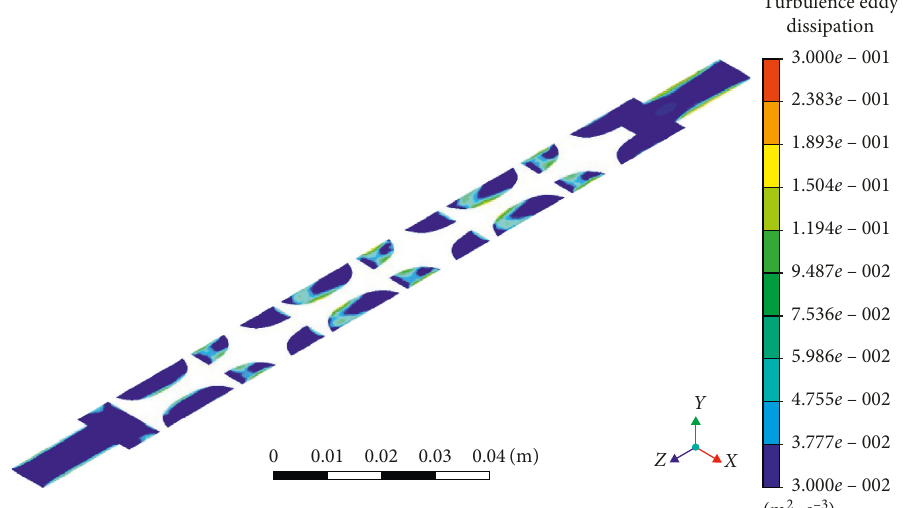
Figure 14: The energy dissipation rate ε in the Kenics static mixer (Re